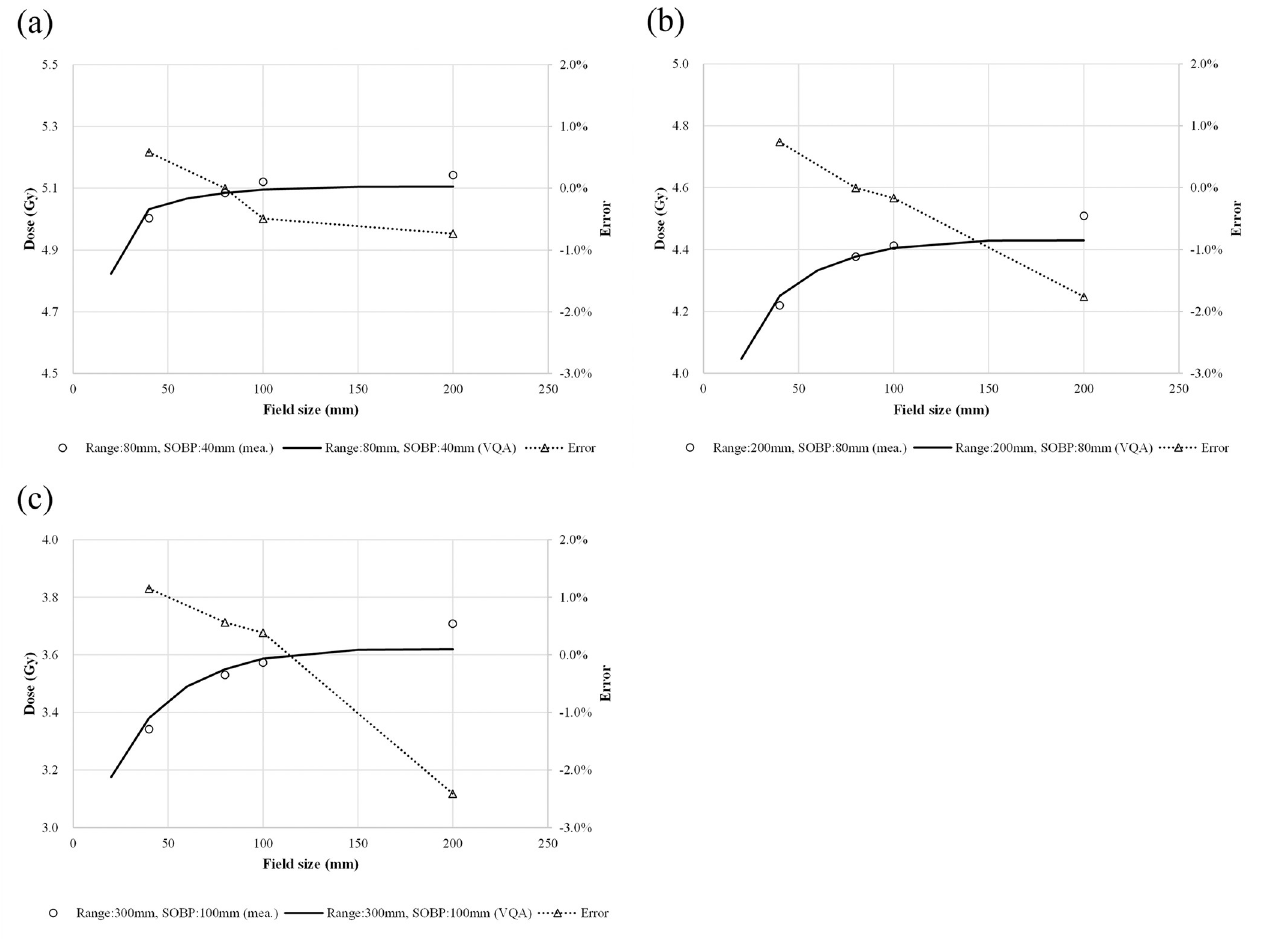
Fig 7. Comparison between the TPS-calculated and -measured absolute point doses at the field center, and the SOBP for selected volumetric dose distributions as functions of field size ranging from 20 × 20 mm 2 to 200 × 200 mm 2 . The circles, solid lines, and dotted lines with triangles represent the measured absolute dose, calculated absolute dose, and errors in the calculation relative to the measurement (a) for an 80-mm range with a 40-mm SOBP, (b) for an 80-mm range with a 200-mm SOBP, and (c) for a 300-mm range with a 100-mm SOBP.